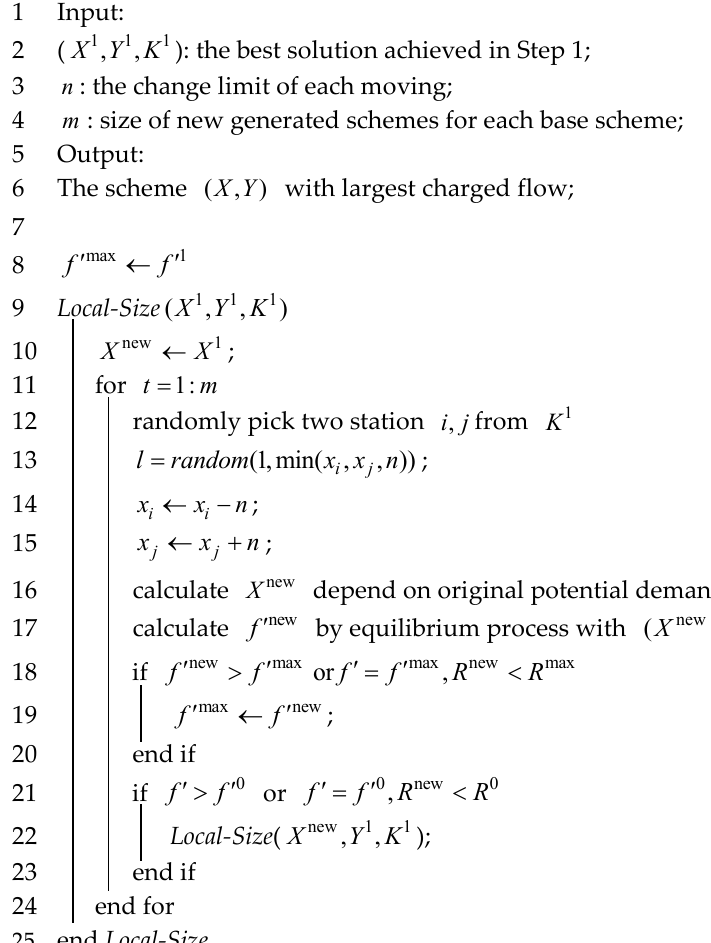
Algorithm 4. The pseudo-code of Step 3.